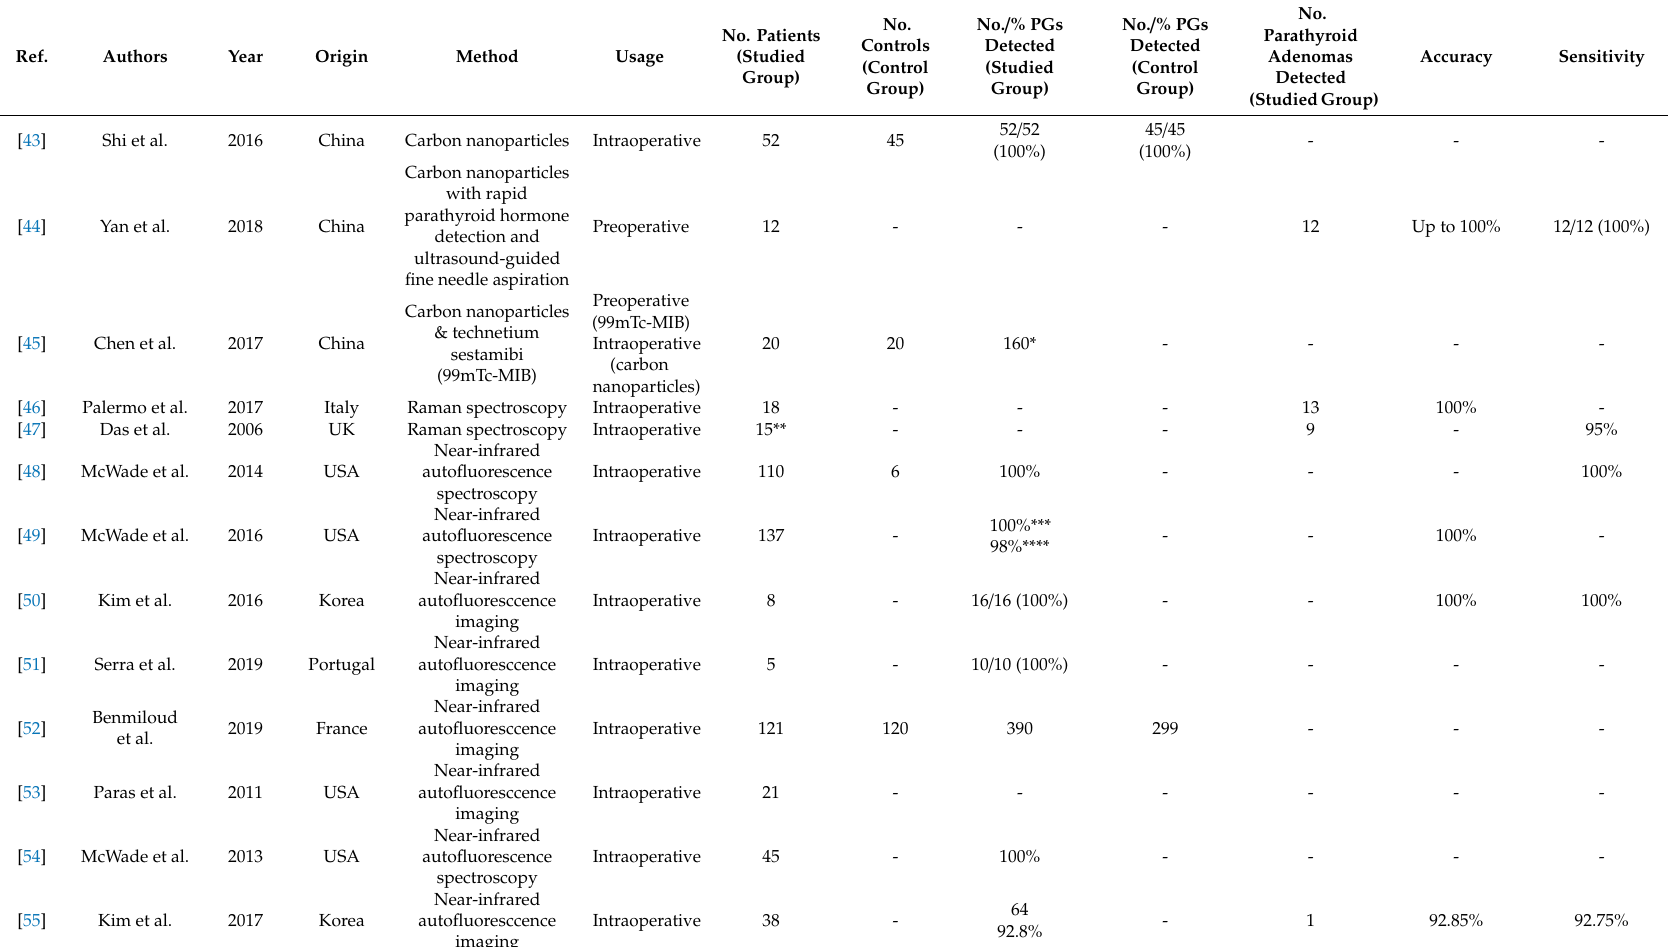
Table 1. Summary of analyzed